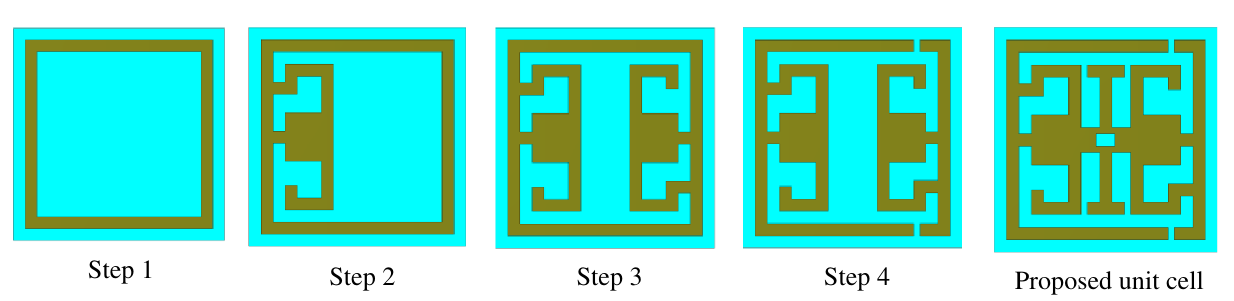
Figure 3. Design evaluation of the structure (CST STUDIO SUITE 2019, https:// www. 3ds. com/ produ cts- servi ces/ simul ia/ produ cts/ cst- studio- suite) 30 .